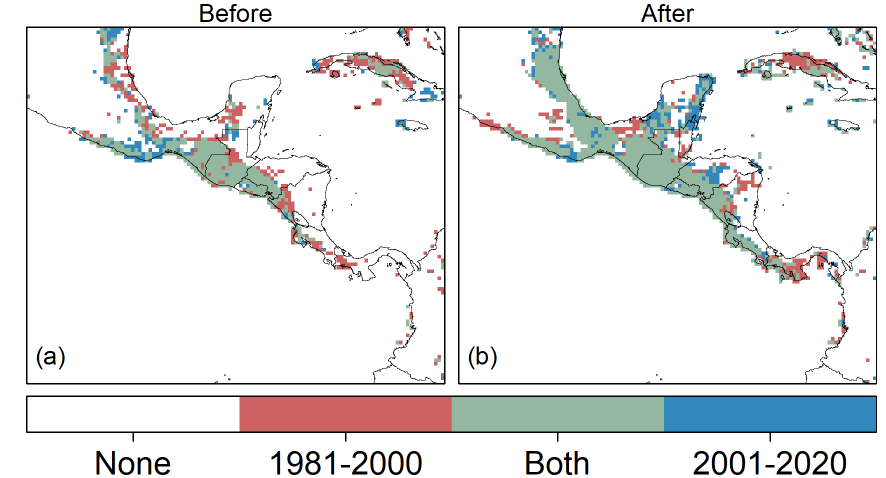
Figure 9. Pixels with an MSD using the original definition varying the dates associated with the windows for the minimum and peaks from (a) 2 weeks earlier to (b) 2 weeks later.